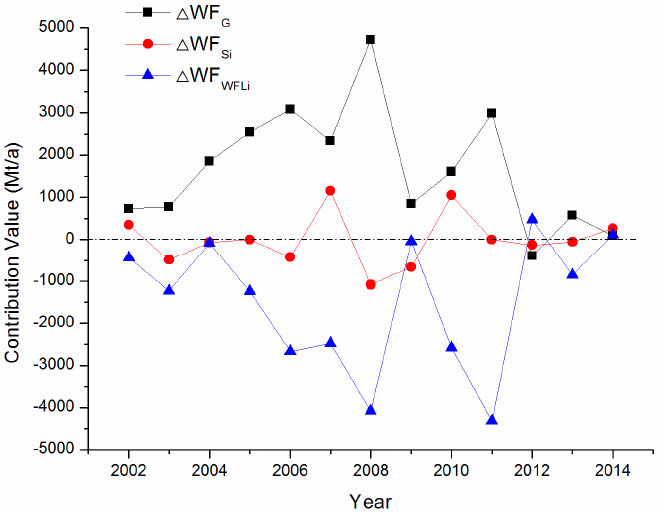
Figure 2. Decomposition analysis of WF factors for China’s textile industry, 2002–2014. Note: WF b , blue water footprint; WF gy , grey water footprint; G , gross annual industrial output.